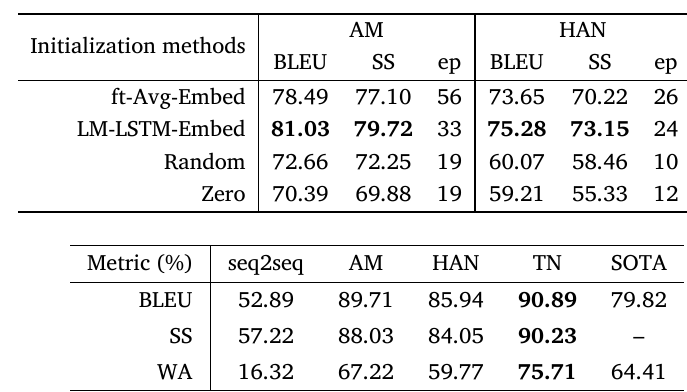
Comparison of evaluation metrics among encoder–decoder